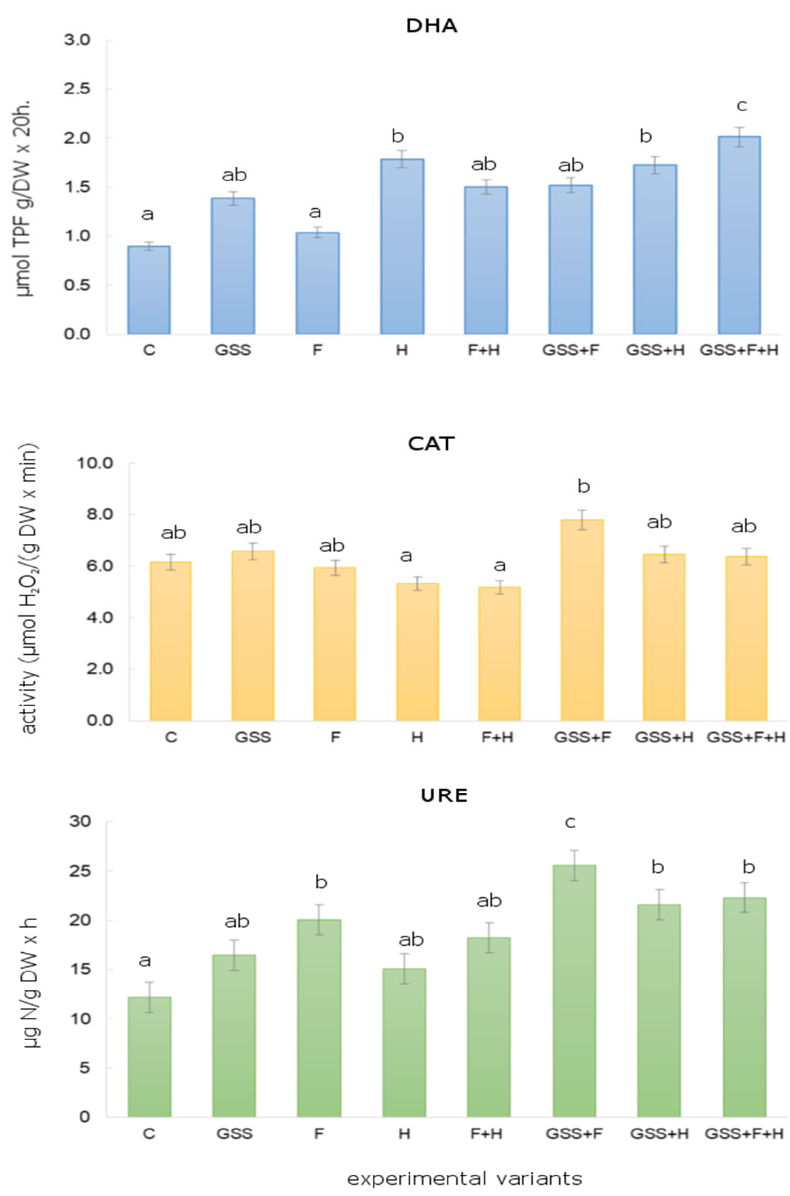
Figure 1. Changes in DHA, CAT and URE activity after GSS and herbicides (MCPA/dicamba) and fungicides (thiophanate-methyl/azoxystrobin) application. (The same letters above bars mean non-significant differences between treatments estimated by Tukey post hoc test at p < 0.05).